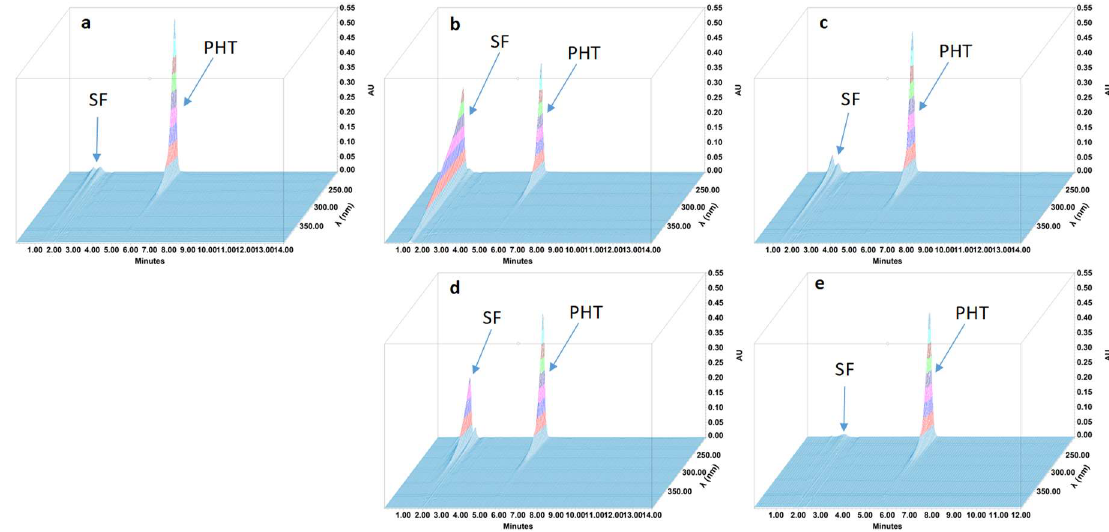
Figure 3. Three - dimensional chromatograms obtained for phenytoin (PHT) oral suspensions after applying different stress conditions. ( a ) No stress; ( b ) HCl 0.5 M at 80 °C for 4 h; ( c ) NaOH 1 M at 80 °C for 4 h; ( d ) H2O2 3% at 80 °C for 4 h; ( e ) 80 °C for 4 h. SF: solvent front.